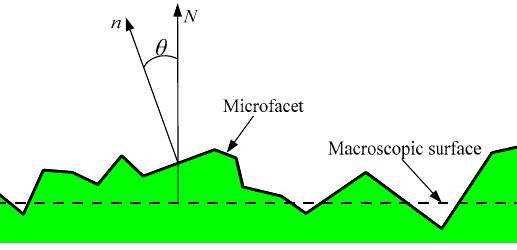
Figure 2. Normal declination angle of the microfacet.